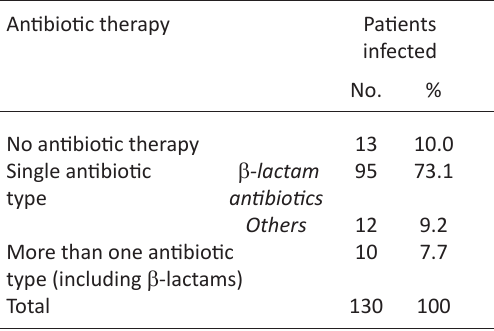
Table 2. Antibiotic therapy of the 130 MRSA infected patients during their hospital stay Antibiotic therapy